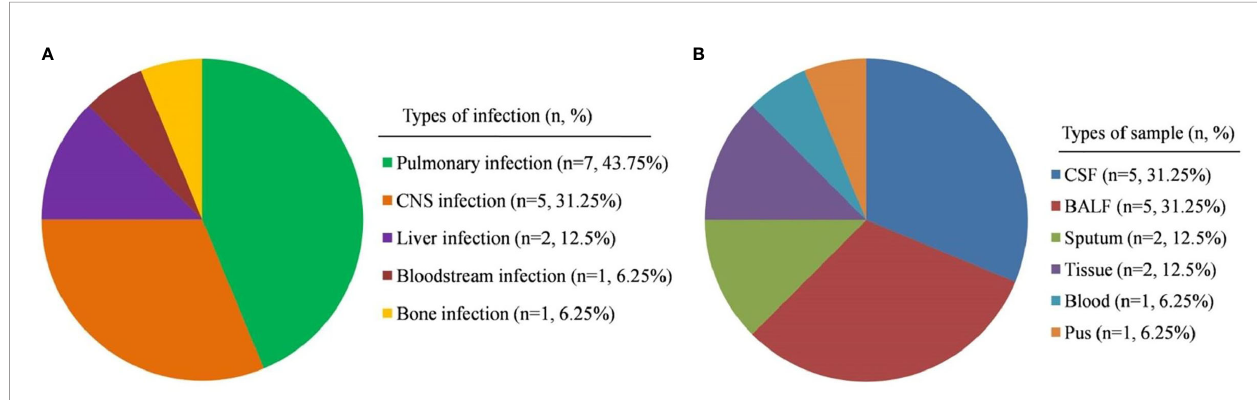
FIGURE 2 | Composition of patients and samples types. (A) Type of suspected infection in the PID patients included in this study. (B) Types of sample collected in this study. CNS, central nervous system; CSF, cerebrospinal fl uid; BALF, bronchoalveolar lavage fl